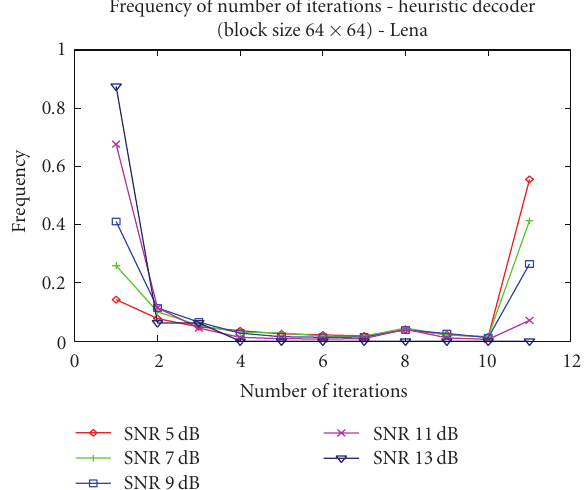
Figure 7: Frequency of number of iterations (heuristic decoder).